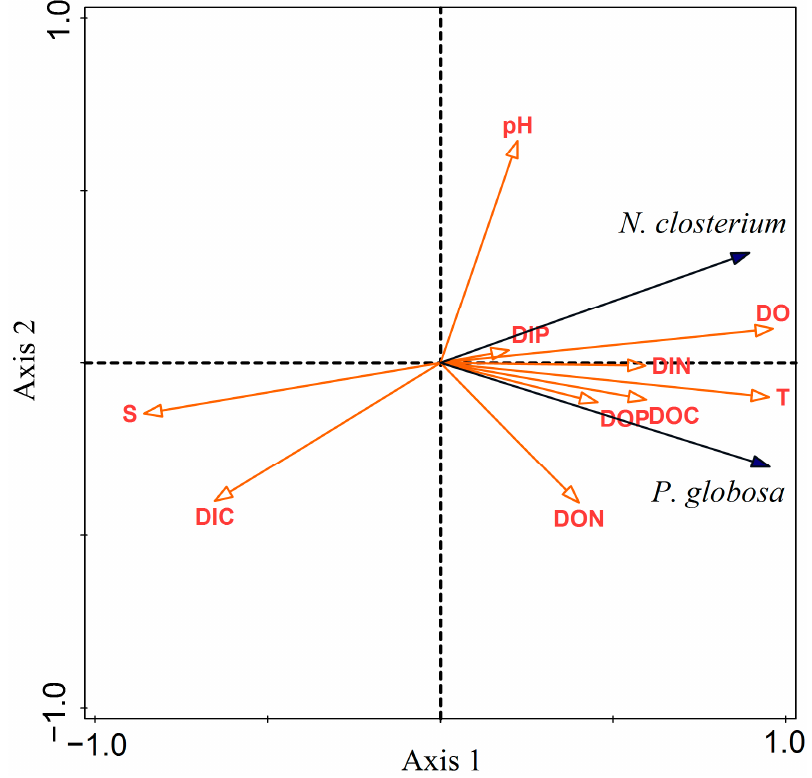
Figure 7. RDA on P. globosa and N. closterium in JSB during spring algal bloom